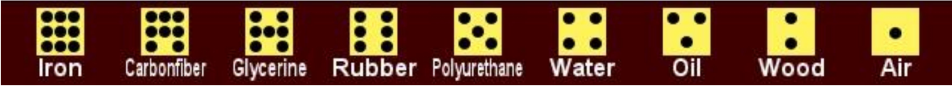
Figure 2. The visual “dots-in-a-box” representation of the density of several materials, reprinted by permission from Springer Nature Customer Service Centre GmbH: Springer, Iterative design of Teaching-Learning Sequences, by D. Psillos and P. Kariotoglou, 2016 and by permission from [20], http://earthlab.uoi.gr/tel/index.php/themeselearn (accessed on 20 March 2021). With a view to preventing or eliminating any misconceptions, such as “all hollow objects float” or “objects with air always float”, as reported in the study by Yin et al. [29], we also thought it best to first introduce students to homogenous objects in the variable of solids. In the TLS, density is introduced within the context of floating or sinking of various everyday objects. First, students are introduced to homogeneous and then to composite objects, such as an iron cube and a ship, respectively, using causal relational reasoning, in other words, by comparing the density of the object and liquid, one is able to interpret and/or predict the FS of each object